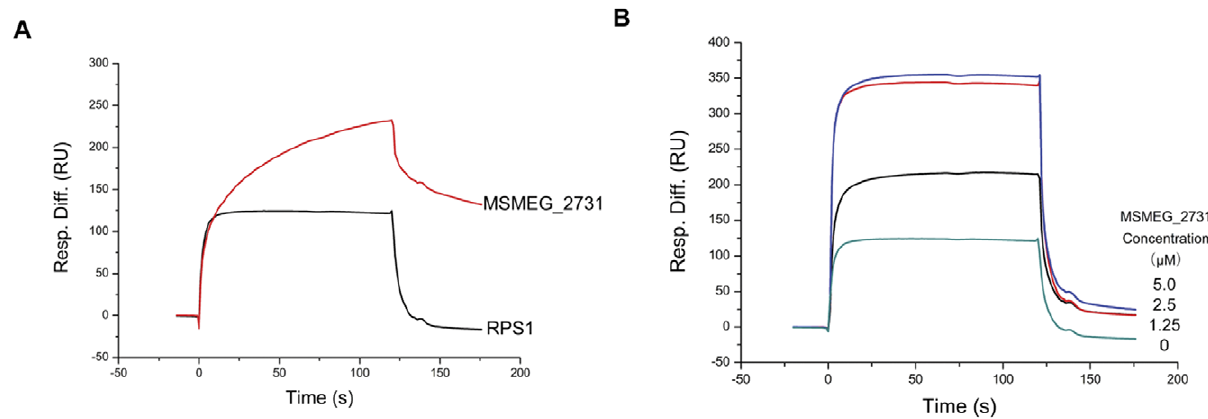
Figure 5. The MSMEG_2731-RPS1 complex interacts with RNA. (A) RNA was immobilized on a SA chip at 100 RU in running buffer containing 25 mM Tris-HCl (pH 7.4), 150 mM NaCl and 0.005% (v/v) Tween 20. RPS1 (2.5 m M) and MSMEG_2731 (2.5 m M) were successively passed over the immobilized RNA. The association was monitored for 2 min. RPS1 bound to RNA more quickly, and dissociated from RNA more completely than MSMEG_2731, while MSMEG_2731 bound to RNA with a higher RU. (B) RPS1 and MSMEG_2731 were mixed together at different ratios to obtain the following mixtures, 2.5 m M RPS1 and 1.25 m M MSMEG_2731, 2.5 m M RPS1 and 2.5 m M MSMEG_2731, and 2.5 m M RPS1 and 5 m M MSMEG_2731. The mixtures were successively passed over the immobilized RNA. Association and dissociation were monitored on a Biacore T100. The kinetic profile of the mixture binding to RNA was similar to that of RPS1. The presence of MSMEG_2731 led to a marked rise in the strength of binding, but 5 m M MSMEG_2731 had the same effect as 2.5 m M of